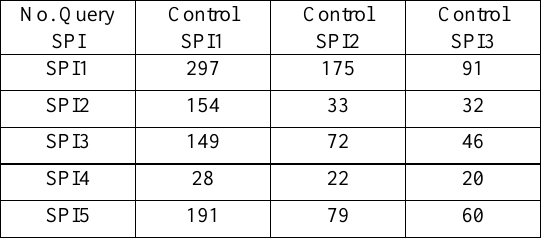
Table 5. Quantity of corresponding pairs between query and control